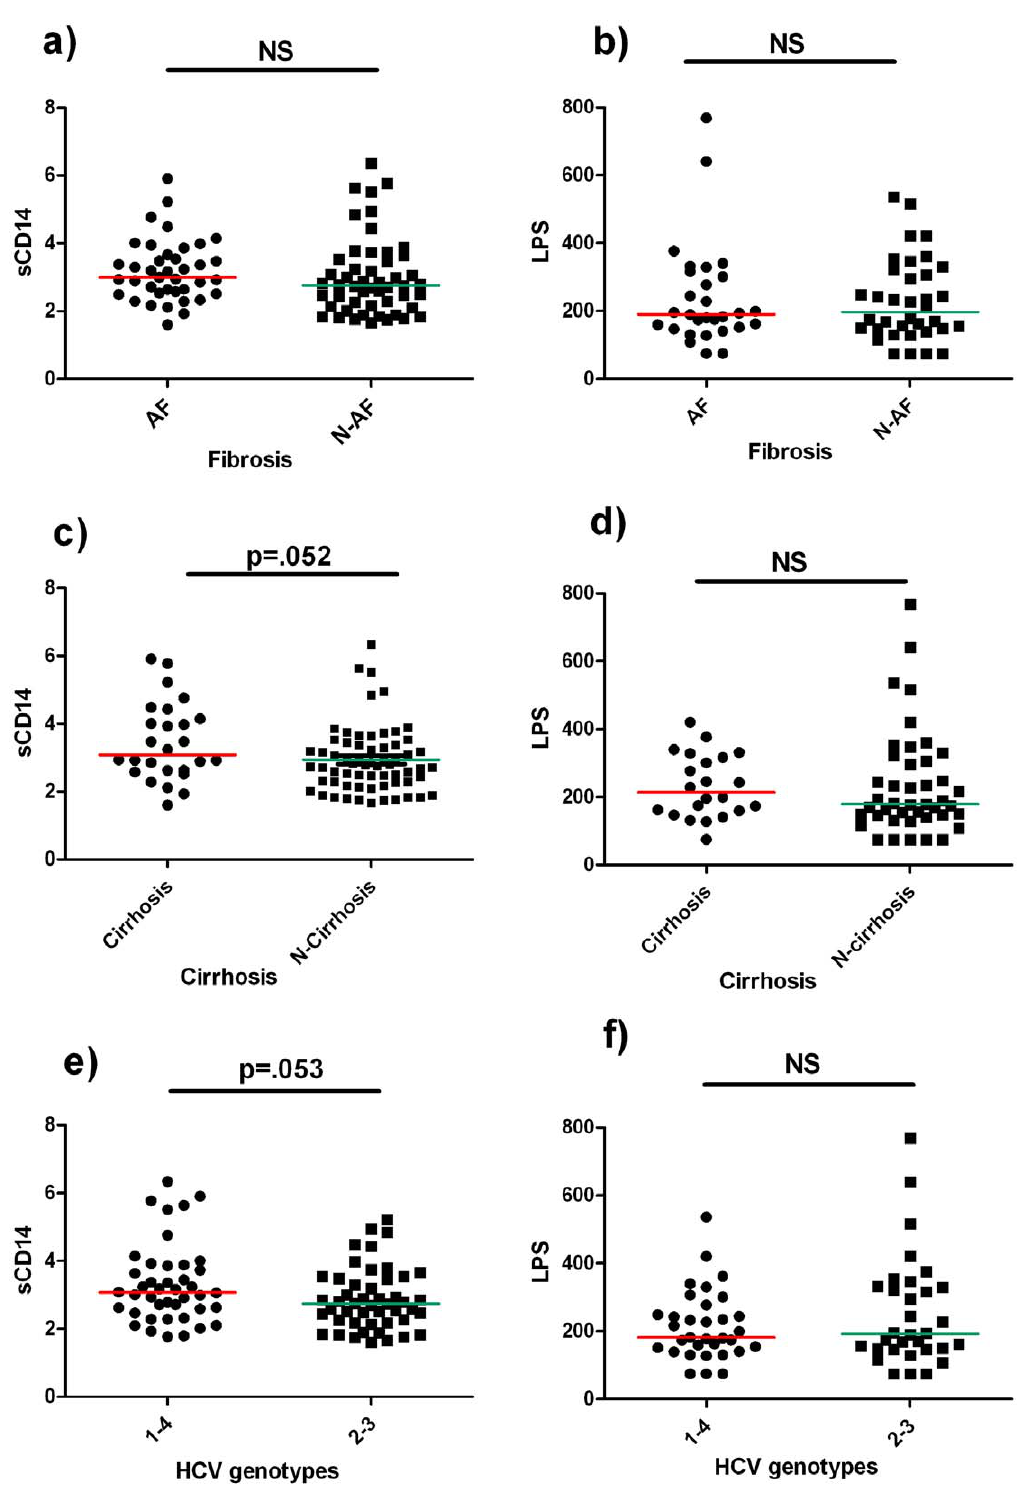
Figure 1. Higher microbial translocation is associated with HCV genotypes 1–4 and cirrhosis. a ) -b ) sCD14 and LPS were compared between patients with advanced fibrosis (AF) and non advanced fibrosis (N-AF). c ) -d ) sCD14 and LPS were compared between patients with cirrhosis and absence of cirrhosis (N-Cirrhosis). e ) -f ) sCD14 and LPS were compared between patients with HCV genotypes 1–4 and genotypes 2–3. Each point represents the value from one subject’s plasma. sCD14 and LPS were measured in plasma samples; sCD14 m g/mL, LPS pg/mL. AF=advanced fibrosis – N-AF=non advanced fibrosis. p-values were assessed by Mann Whitney U test. p . 0.05 was considered non significant (NS).